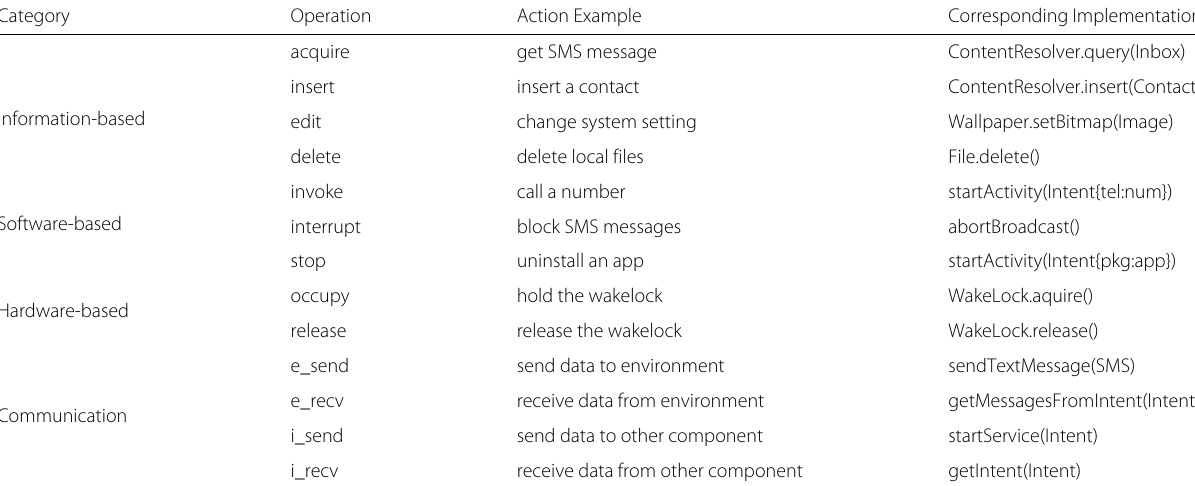
Table 1 The category of actions on Android